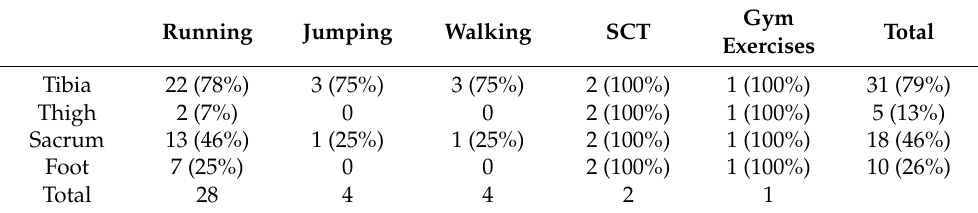
Table 3. Accelerometer placement: absolute number and